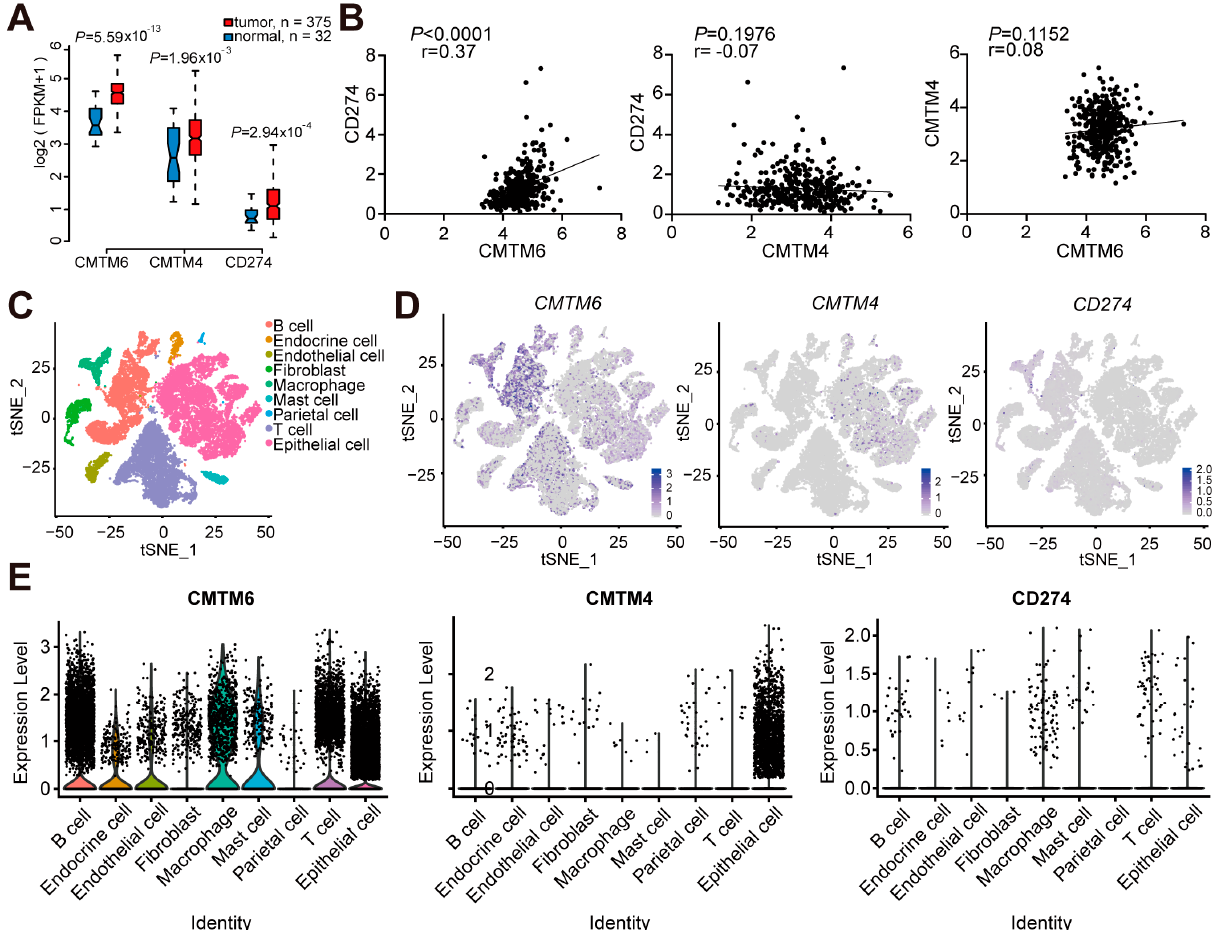
Figure 1. Cellular atlas of gastric tumors revealed different expression patterns of CMTM6 , CMTM4 , and PD-L1 (Raspberry Pi). ( A ) Upregulated mRNA expression of CMTM6 , CMTM4 , and CD274 in stomach adenocarcinoma (STAD) derived from TCGA. ( B ) Correlation of mRNA expression of CMTM6 , CMTM4 , and CD274 by the TCGA dataset, analyzed by the Pearson test. ( C ) The t-SNE plot of high-quality single cells from gastric tumors and non-tumor gastric tissues to visualize cell-type clusters identified by the expression of known marker genes. ( D ) The t-SNE plots showing the expression levels of CMTM6 , CMTM4 , and CD274 in the clusters described above. ( E ) Violin plots showing the smoothed expression distribution of CMTM6 , CMTM4 , and CD274 in the clusters described